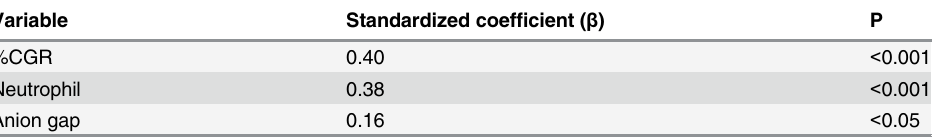
The above 3 variables explained 42% of the expected NGAL value (adjusted r 2 ). Variables entered but excluded by stepwise analysis were age, gender, serum creatinine, and blood WBC count. N =